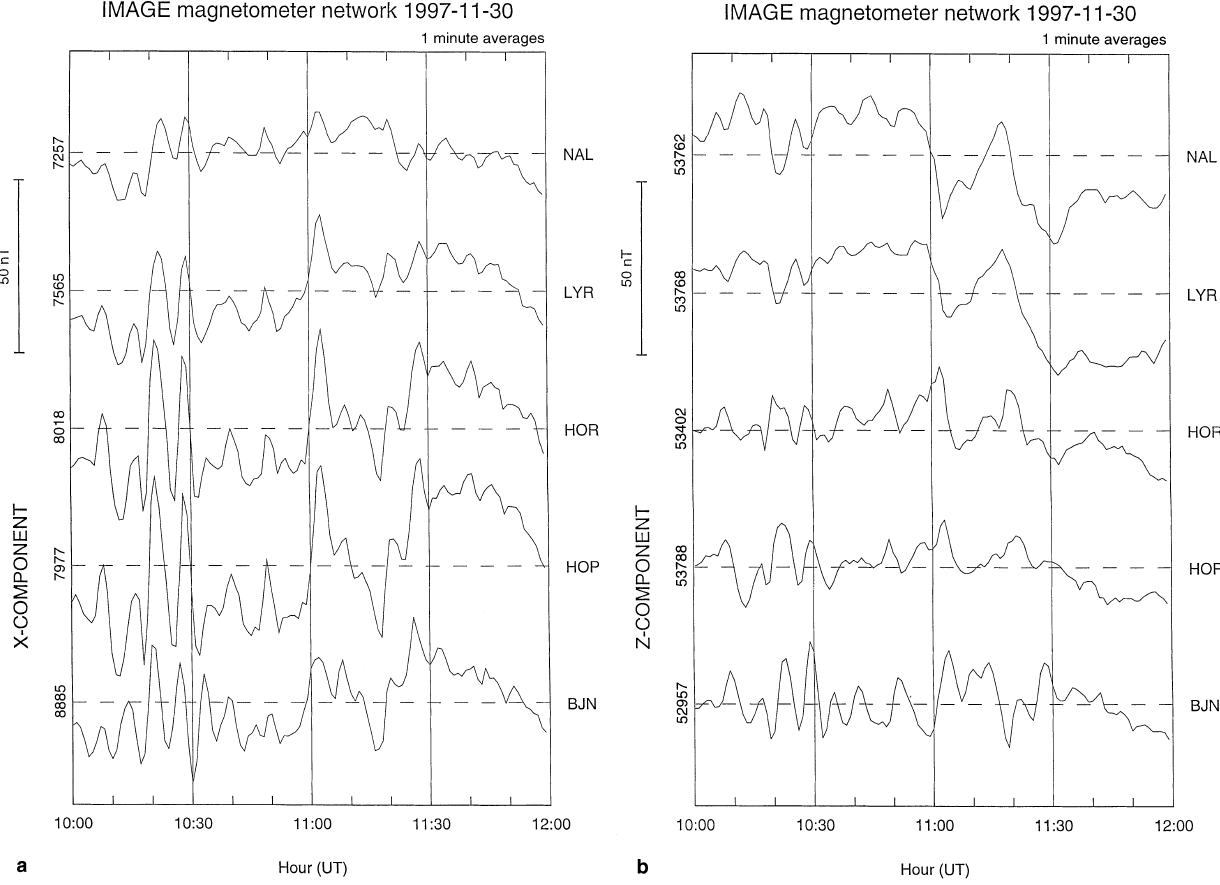
Fig. 6a. X- and b Z-component magnetograms from Ny A˚ lesund ( NAL ; 75 (cid:14) MLAT), Longyearbyen ( LYR ; 74 (cid:14) MLAT), Hornsund ( HOR ; 73 (cid:14) MLAT), Hopen ( HOP ; 2 (cid:14) MLAT) and Bjrnya ( BJN ; 71 (cid:14) MLAT) for the time interval 1000–1200 UT on 30